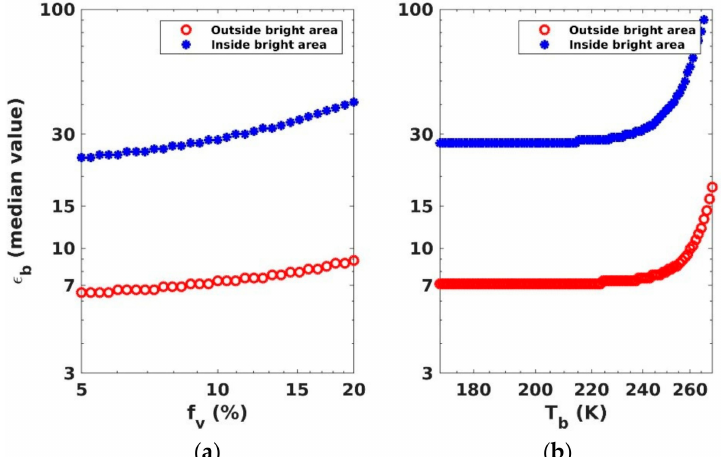
Figure 8. ( a ) Trend of the median value ε b as a function of f v computed from the posterior pdf p p ( ε b ∗ , f v ∗ ) inside (blue) and outside (red) the bright area. ( b ) Trend of the median value ε b as a function of T b computed from the posterior pdf p p ( ε b ∗ , T b ∗ ) inside (blue) and outside (red) the bright